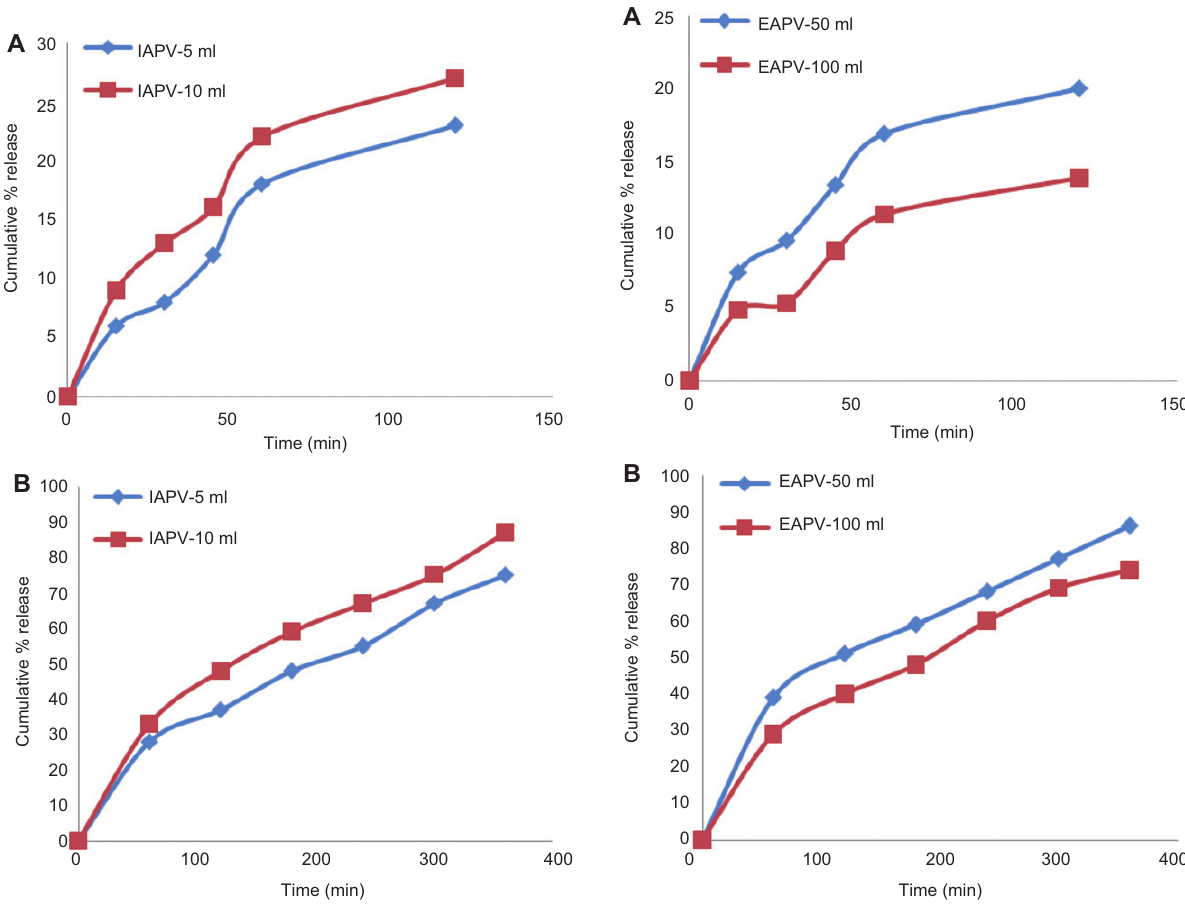
Figure 4 Release profiles of aspirin-loaded ethyl cellulose micro- particles: variation of internal phase volume (A) in pH 1.2 acid solu- tions and (B) in pH 7.4 PB solutions.